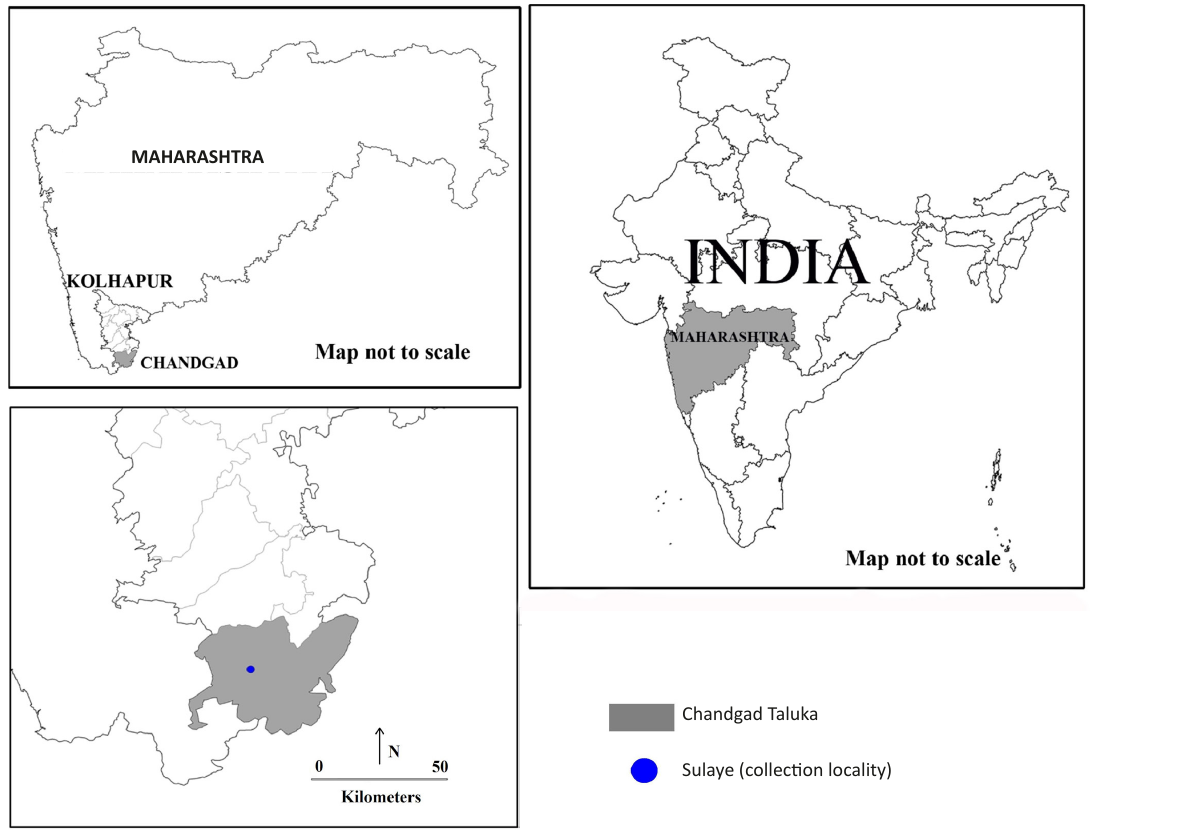
Figure 1. Location of recorded species from Chandgad, Maharashtra,